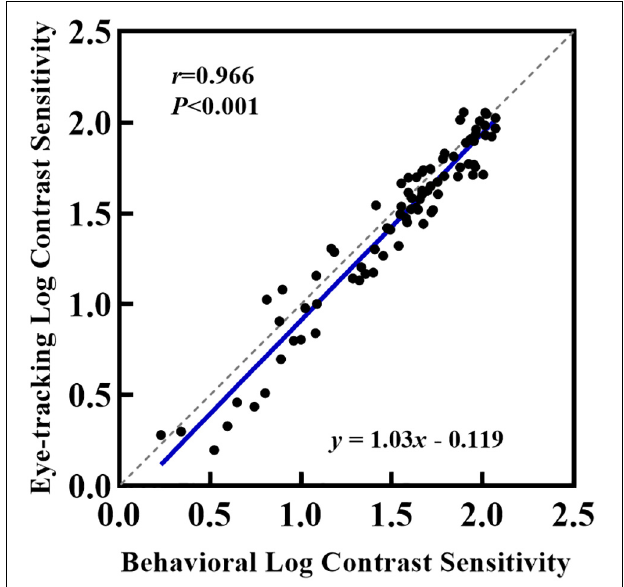
FIGURE 4 | Relationship between logCS estimated from the conventional perceptual and eye tracking report. Each point represents one of the 27 participants who completed eye tracking and behavioral measurements under BCVA. The solid blue line represents the best linear fit to the